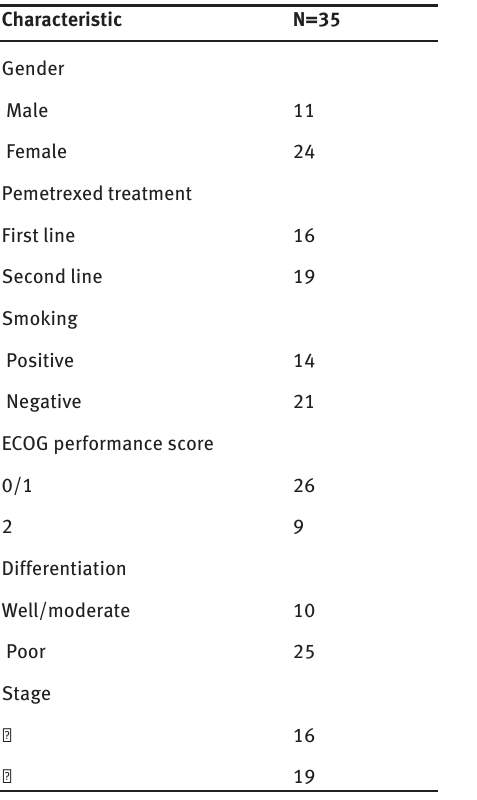
Table 1: General characteristics of the included 35 lung adenocarcinoma patients.